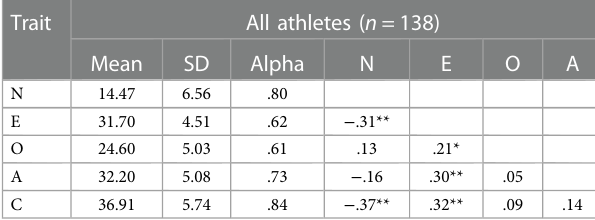
TABLE 1 Descriptive statistics, reliability coef fi cients (alpha), and correlations for all traits.